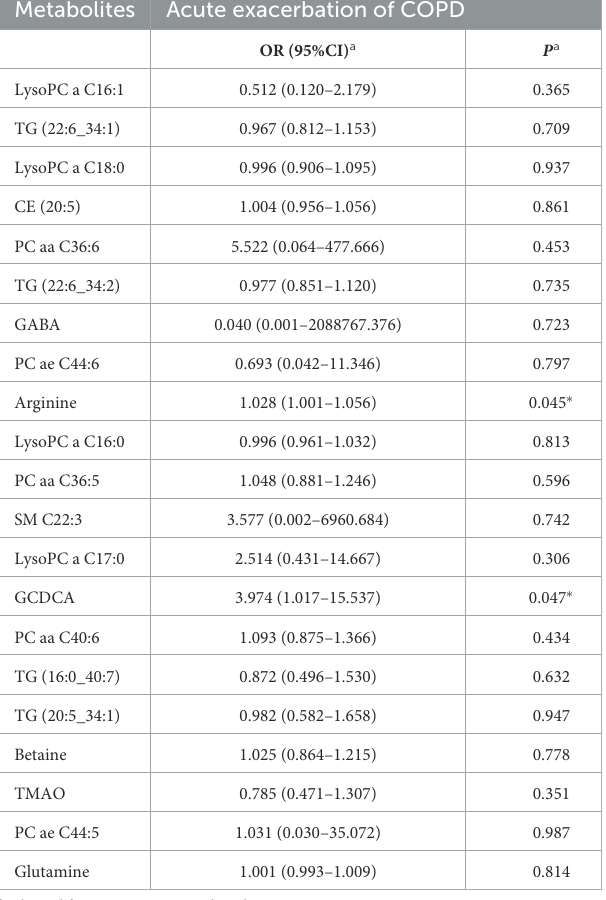
TABLE 3 Relationship between metabolites and AECOPD during the 3 months of follow-up.